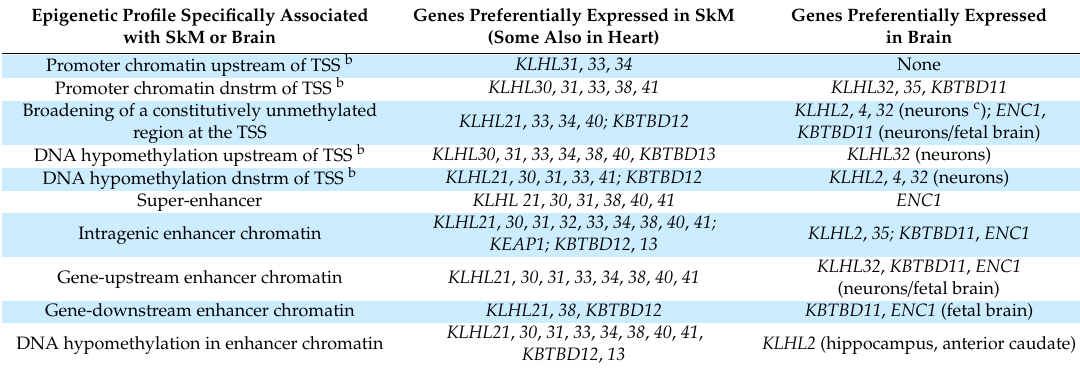
Table 3. Epigenetic patterns associated with tissue-specific expression of KLHL genes in skeletal muscle or brain a